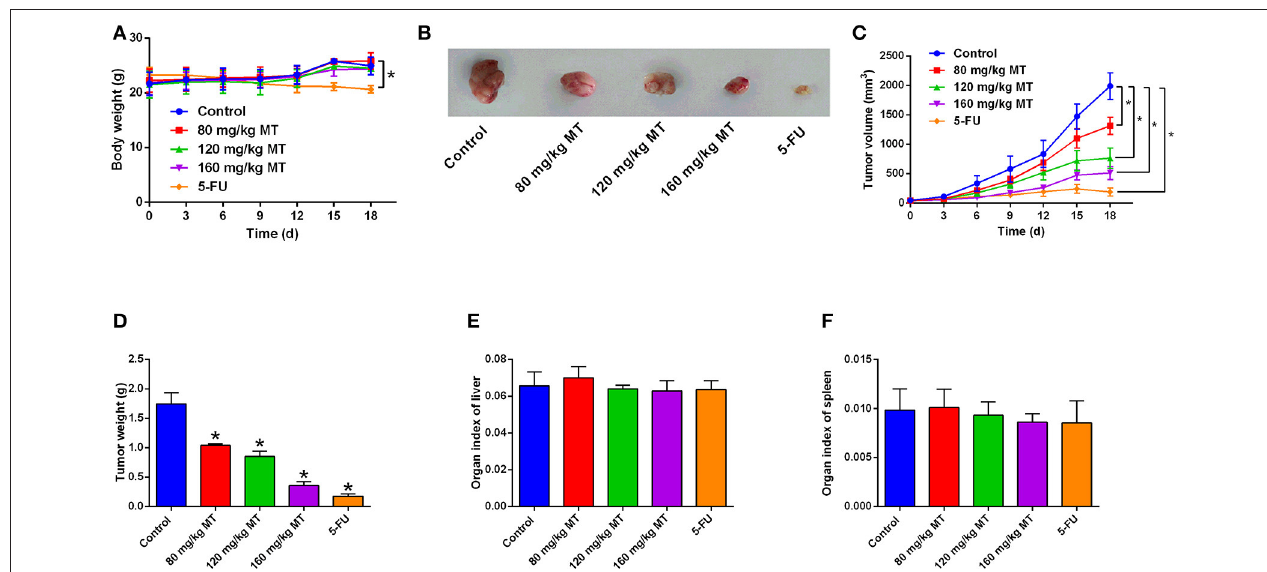
FIGURE 5 | MT inhibits tumor growth in vivo . (A) Body weight of mice after different treatments were determined every day. (B) Representative images of tumor tissues dissected from mice after different treatments. (C) The tumor volumes were measured every 3 days for 19 days in different treatment groups. (D) The tumor weight was measured after all nude mice were sacrificed. (E,F) Organ index of liver (E) and spleen (F) in the nude mice after different treatments were determined. N = 5. * P < 0.05 compared to the corresponding control groups.